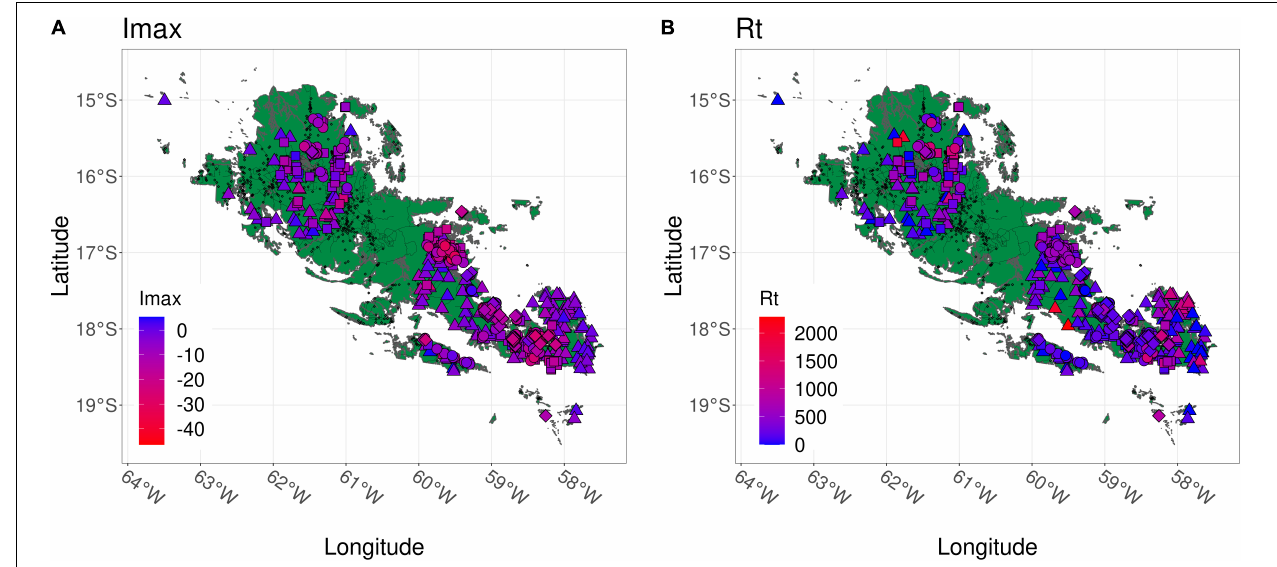
FIGURE 6 | Spatial map showing the distribution of plots and values of the resilience metrics. (A) Maximum impact I max (expressed as percentage loss) and (B) recovery time Rt, the number of days after fire (or Aug 24 2010 for Control data points) until the baseline was reached again. Each shape corresponds to a plot experiencing a different fire frequency ( : Ctrl = control, no fire; (cid:78) : F1 = 1 fire event; (cid:4) : F2 = 2 fire events; (cid:7) : F3 = 3 fire events), whereas the color gradient of each point indicates the higher or lower values of the resilience metric. The area corresponds to the area in green in Figure 1 (cid:32)